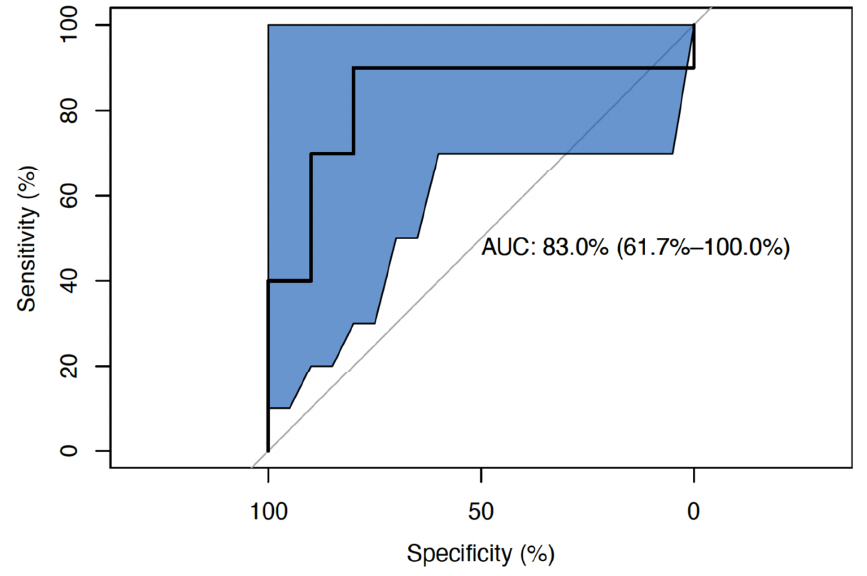
Figure 3. Use of Receiver Operating Characteristic curve analysis for miR-21, miR-31, and miR-150 in differentiating tumour tissues from tumour-associated normal tissues in our validation set.